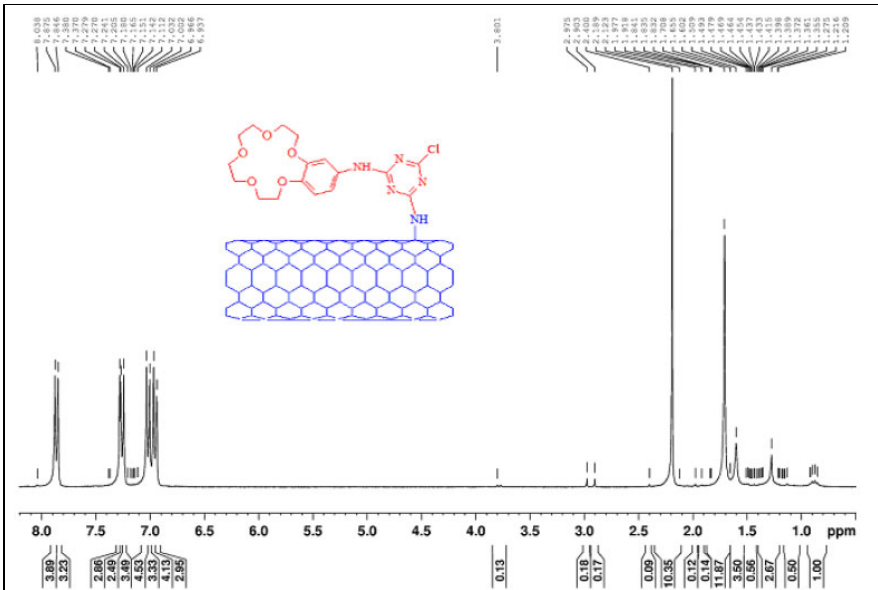
Figure 28. NMR analysis of a mixed matrix membrane made from polysulfone (PSf) and carbon